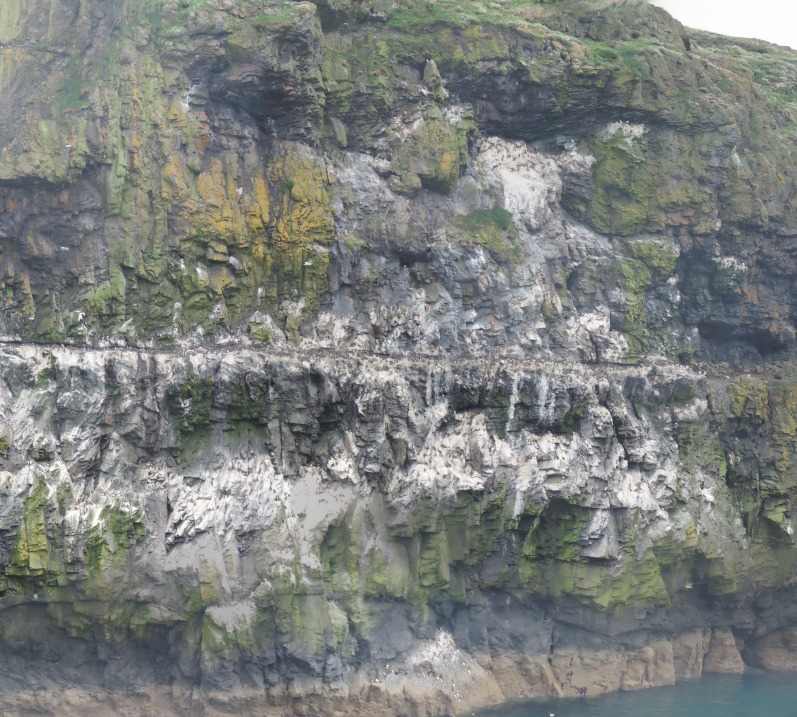
The largest guillemot colony on Skomer; the Wick.A long ledge runs roughly half way down the cliff. This has sections where it expands into large platforms and others, such as that to the left of the picture, where it forms a long, narrow ledge.